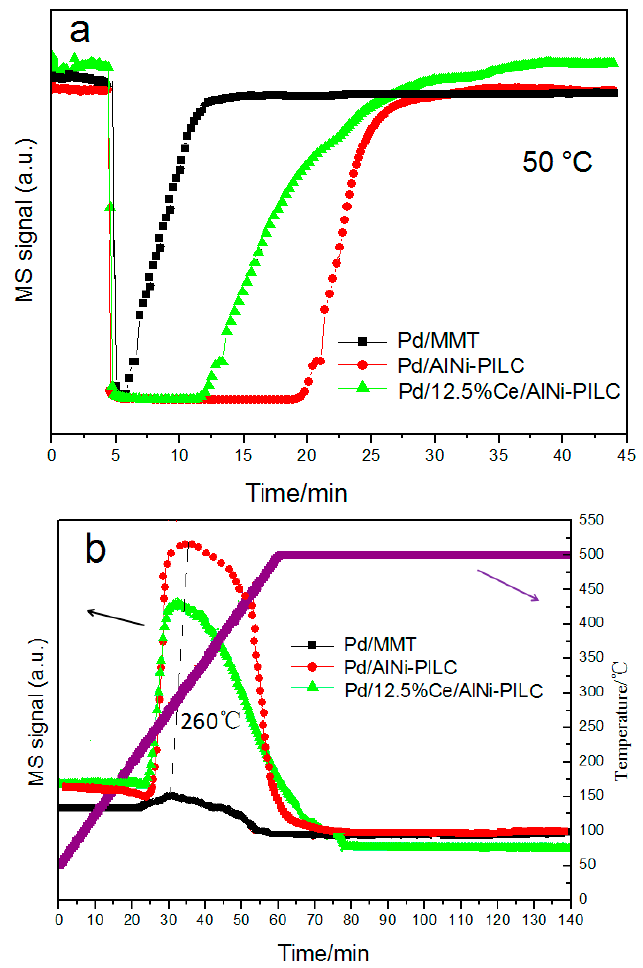
Figure 7. ( a ) Benzene ( m / z = 78) adsorption profiles in temperature-programmed desorption (TPD) over Pd/AlNi-PILC, Pd/12.5% Ce-AlNi-PILC, and Pd/MMT catalysts; ( b ) benzene ( m / z = 78) desorption profiles in TPD over Pd/AlNi-PILC, Pd/12.5% Ce-AlNi-PILC, and Pd/MMT catalysts.